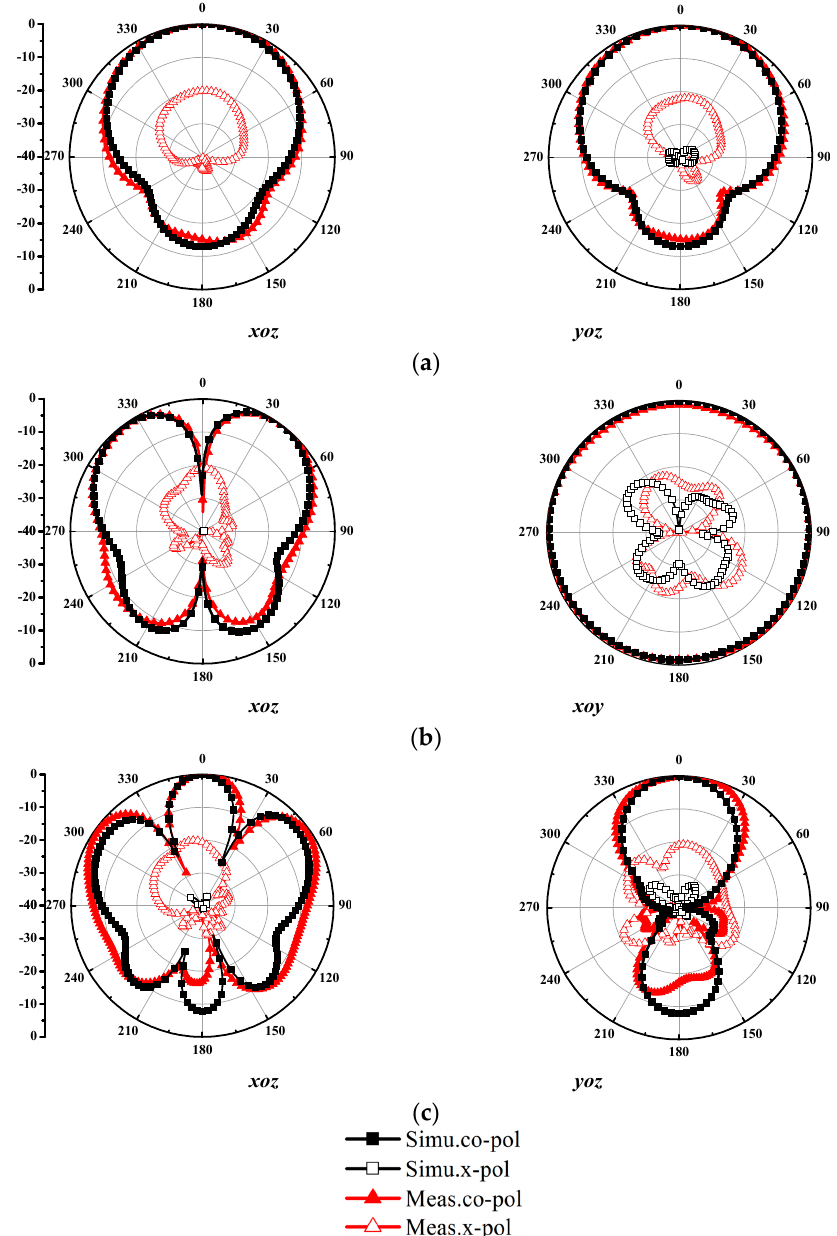
Figure 11. Simulated and measured radiation patterns of the designed antenna in xoy, xoz, and yoz planes: ( a ) 1.80 GHz; ( b ) 3.80 GHz; ( c ) 5.35 GHz.